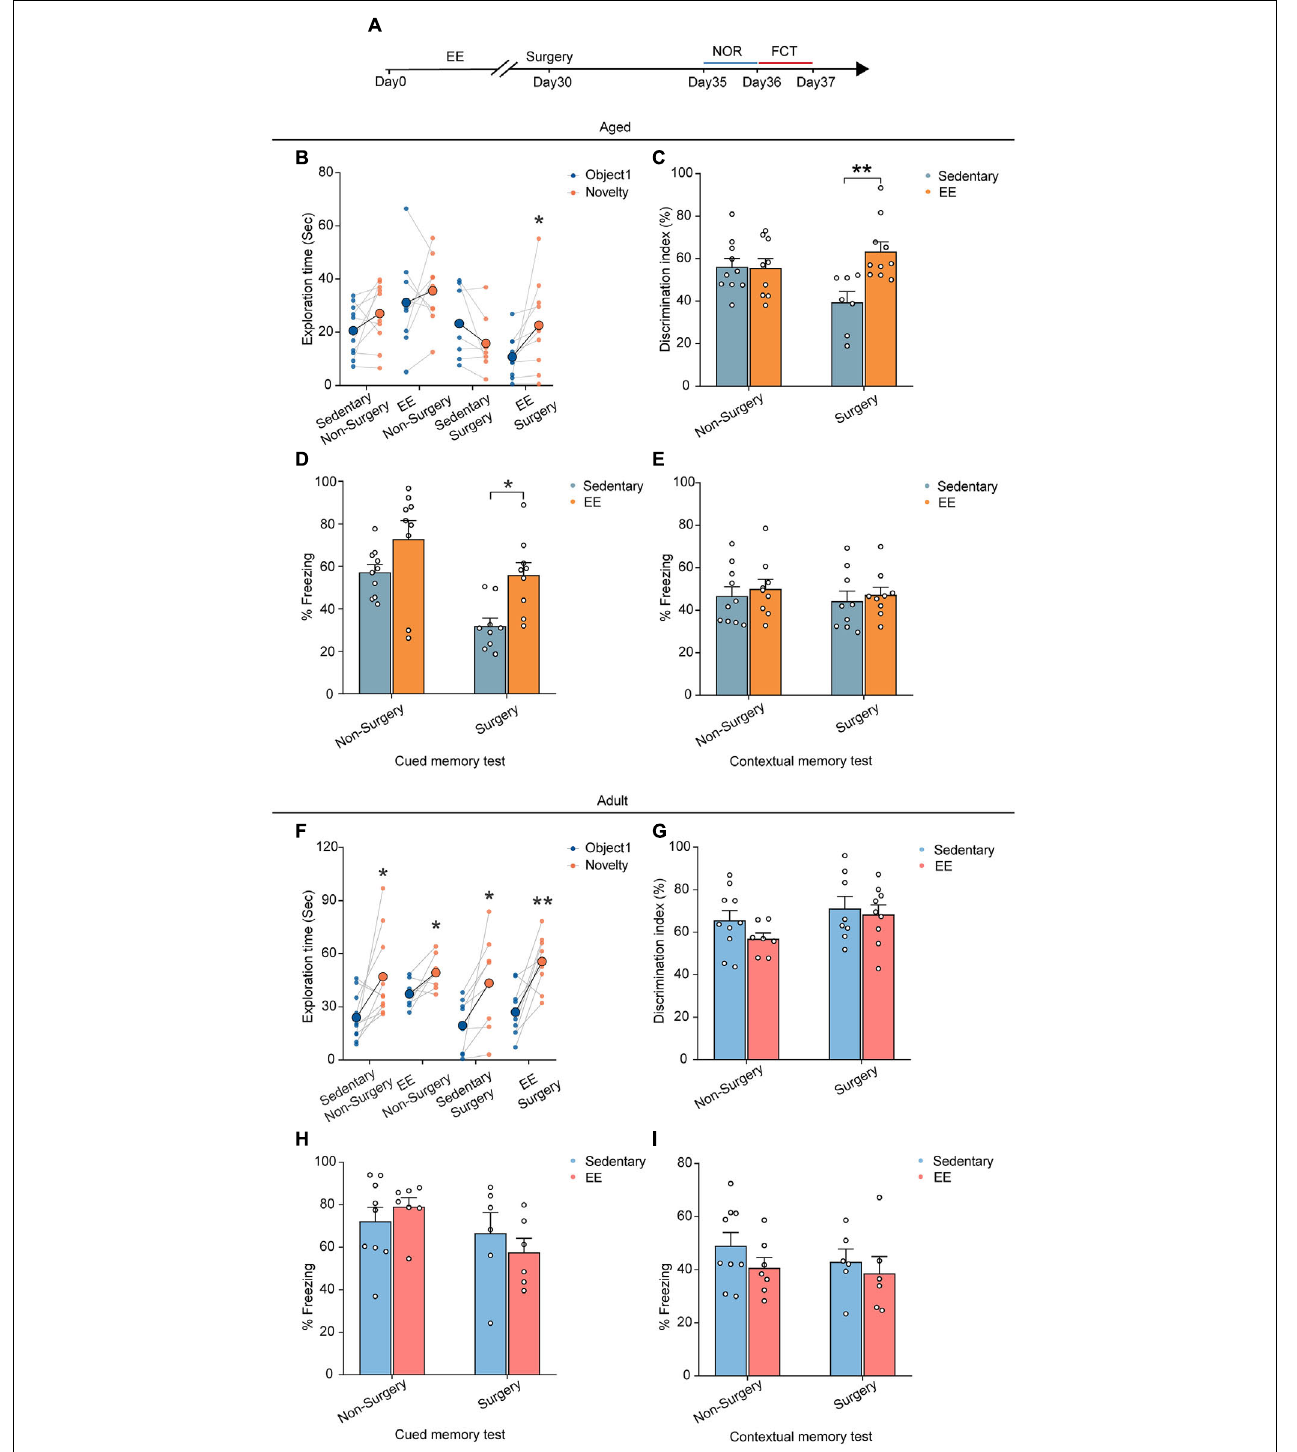
FIGURE 6 | EE alleviated the cognitive dysfunction induced by surgery in the aged mice. (A) Schematic outline of experimental approach. (B) The exploration time in NOR test of the aged mice. (C) The discrimination index in NOR test of the aged mice. (D) The percentage of freezing time in the auditory-cued memory test of the aged mice. (E) The percentage of freezing time in the contextual memory test of the aged mice (F) The exploration time in NOR test of the adult mice. (G) The discrimination index in NOR test of the adult mice. (H) The percentage of freezing time in the auditory-cued memory test of the adult mice. (I) The percentage of freezing time in the contextual memory test of the adult mice. Data was presented as mean ± SEM. Data were analyzed by two-tailed Student’s paired t -test or two-way ANOVA and Bonferroni’s correction; * P < 0.05, ** P < 0.01.